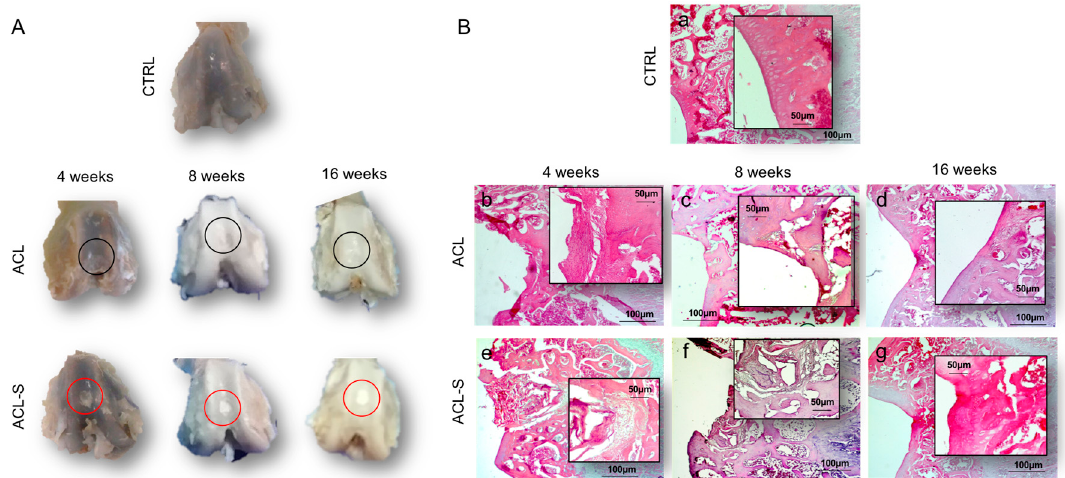
Figure 2. Cartilage repair evaluation through macroscopic and microscopic evaluation. ( A ) Macroscopic evaluation of repair capacity of femoral articular cartilage explants after defect creation indicated with black circles (ACL group) and in vivo scaffold implantation indicated with red circles (ACL-S group) at 4-, 8- and 16-weeks; ( B ) Histological evaluation by H&E staining of femoral articular cartilage samples after defect creation (ACL group) and in vivo scaffold implantation (ACL-S group) at 4-, 8- and 16-weeks: ( a ) control sample presenting a normal cartilage cytoarchitecture; ( b ) ACL group sample at 4-weeks presenting fibrocartilage formation at the defect area level; ( c,d ) ACL group sample at 8- and 16-weeks presenting cartilage calcification corresponding to the defect area level; ( e ) ACL-S group sample at 4-weeks presenting a prechondrogenic mesenchyme-like tissue features at the interface between scaffold and the peri-native tissue; ( f ) ACL-S group sample at 8-weeks presenting matrix deposition within the scaffold, suggesting host cell recruitment and their chondrogenic differentiation; ( g ) ACL-S group sample at 16-weeks presenting a total scaffold reabsorption and replacement with a newly formed cartilage-like tissue. Scale bar: 100 μ m. The inserts represent the image magnifications (scale bar: 50 μ m) to evidence the morphology changes observed in a time-dependent manner.